Question: Which kind of chart has been used to present this data?
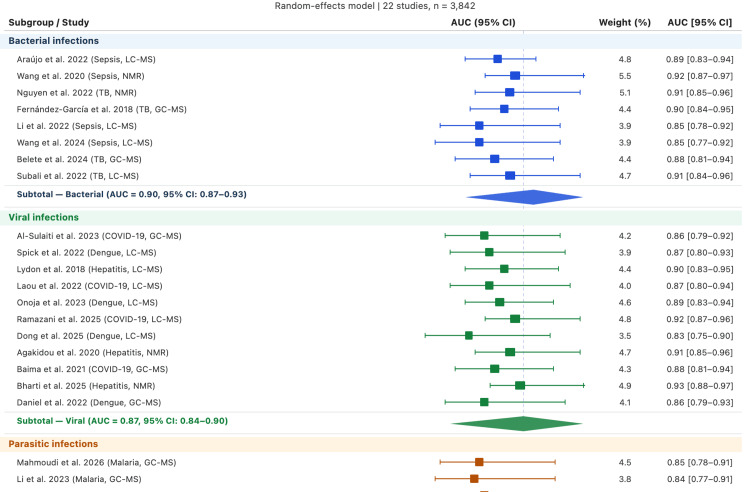
Answer: forest